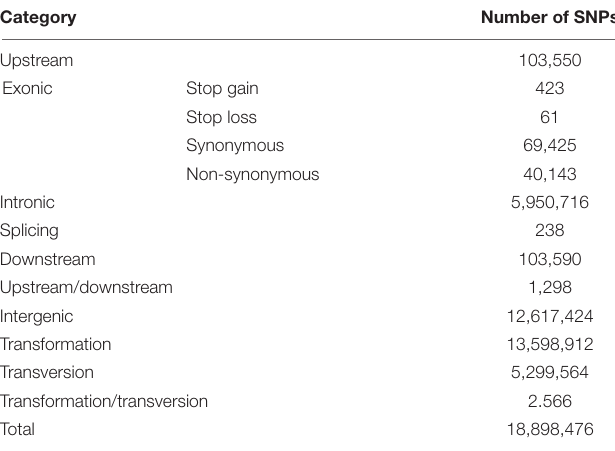
TABLE 2 | Characteristics and numbers of identified SNPs for 32 individuals of four breeds fine-wool sheep (sequencing depth 30 ×